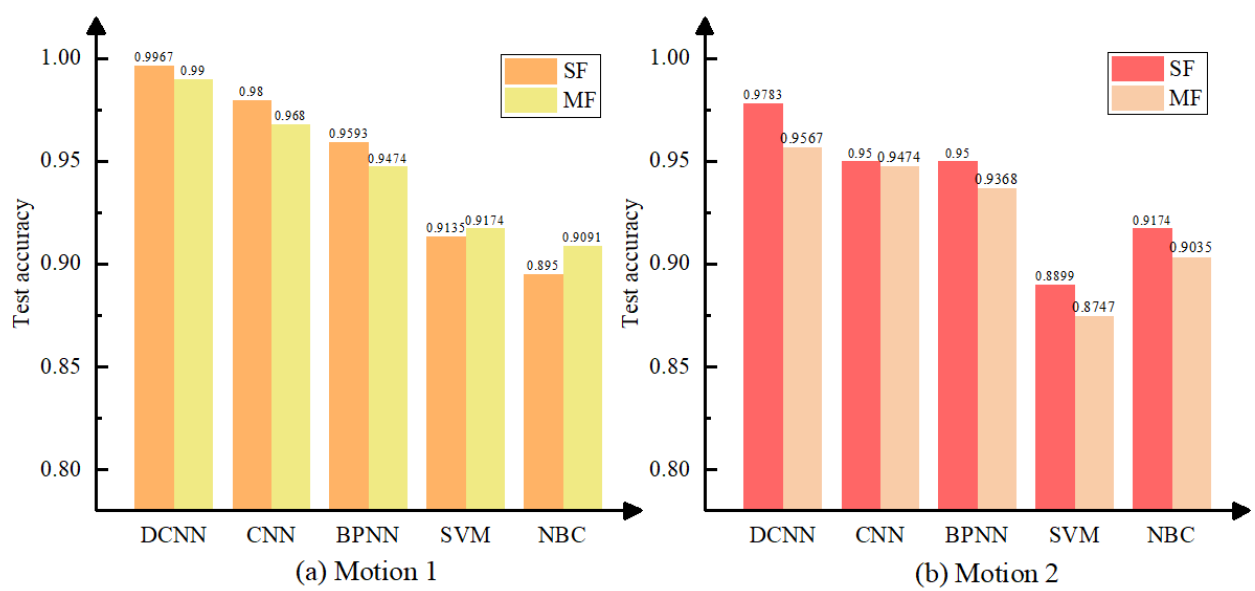
Figure 12. Comparisons of recognition accuracies in the second stage. ( a ) Motion 1; ( b ) Motion 2.